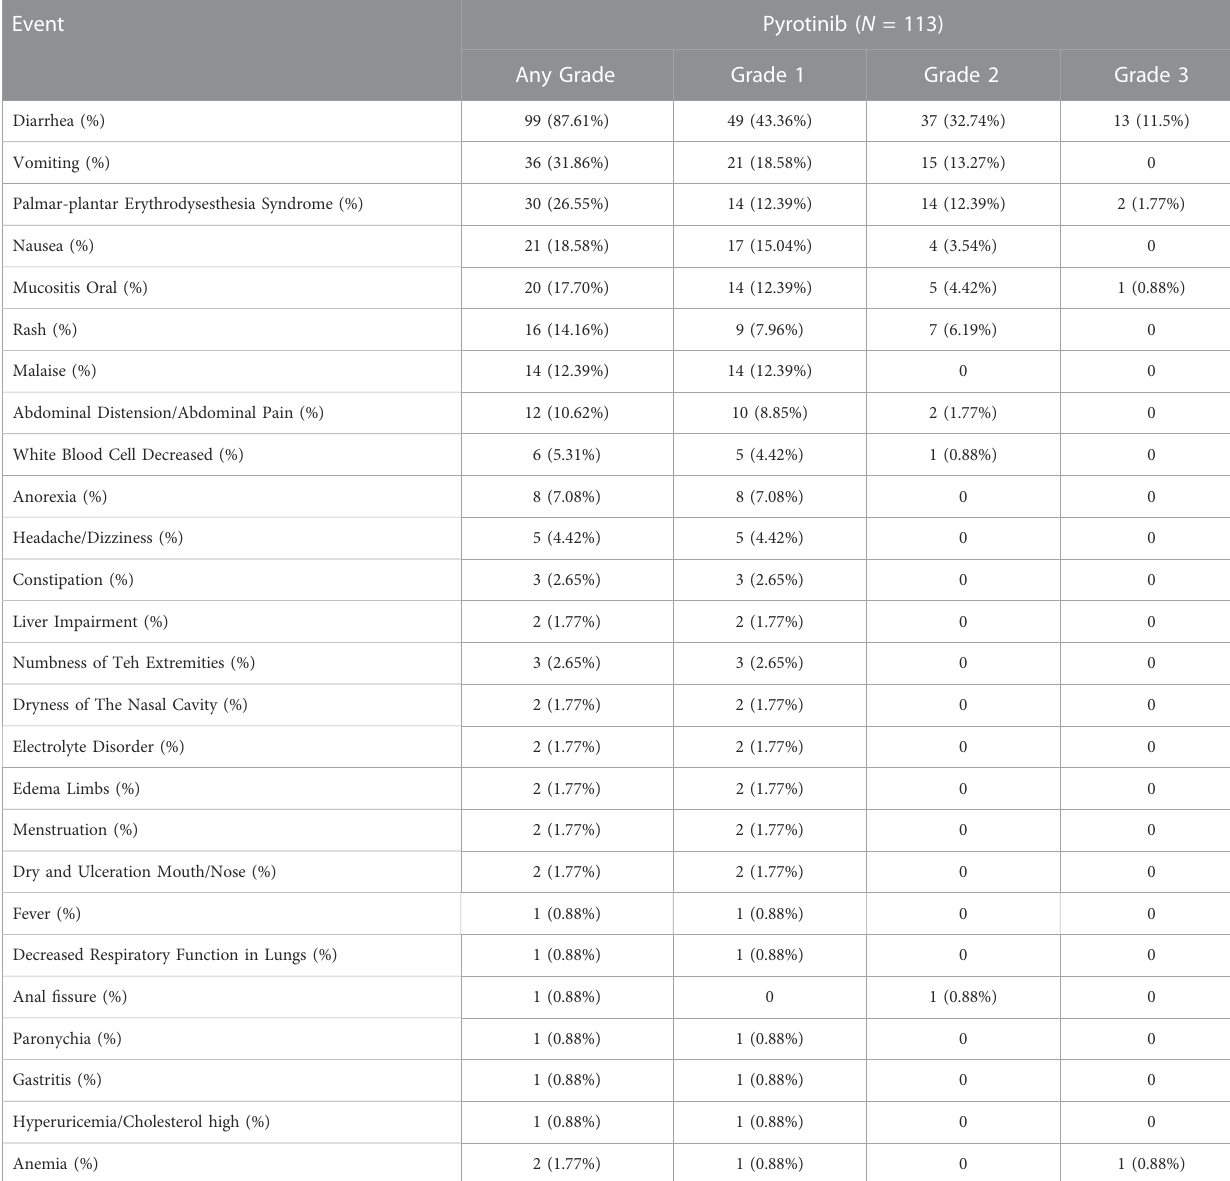
TABLE 3 Adverse events of matched-paired patients with different treatments.